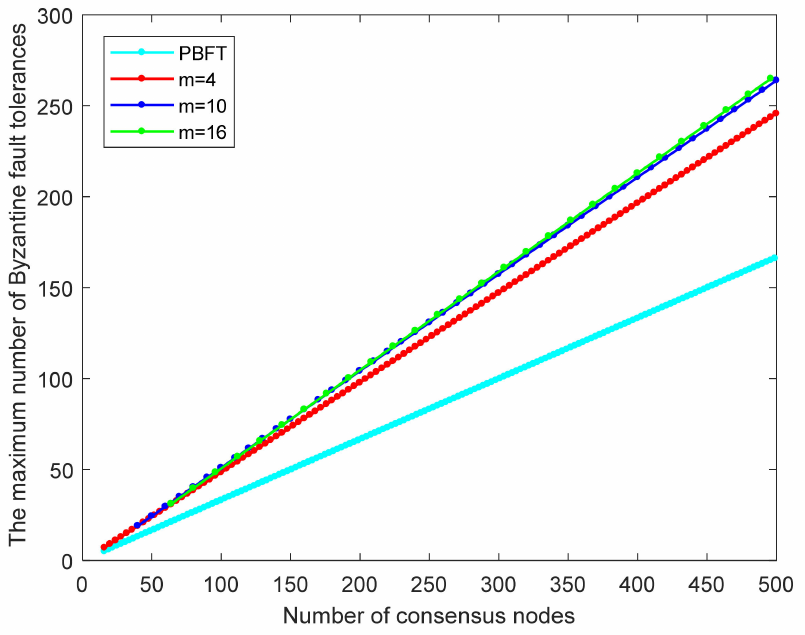
Figure 7. The maximum number of Byzantine fault tolerances of TB-PBFT and